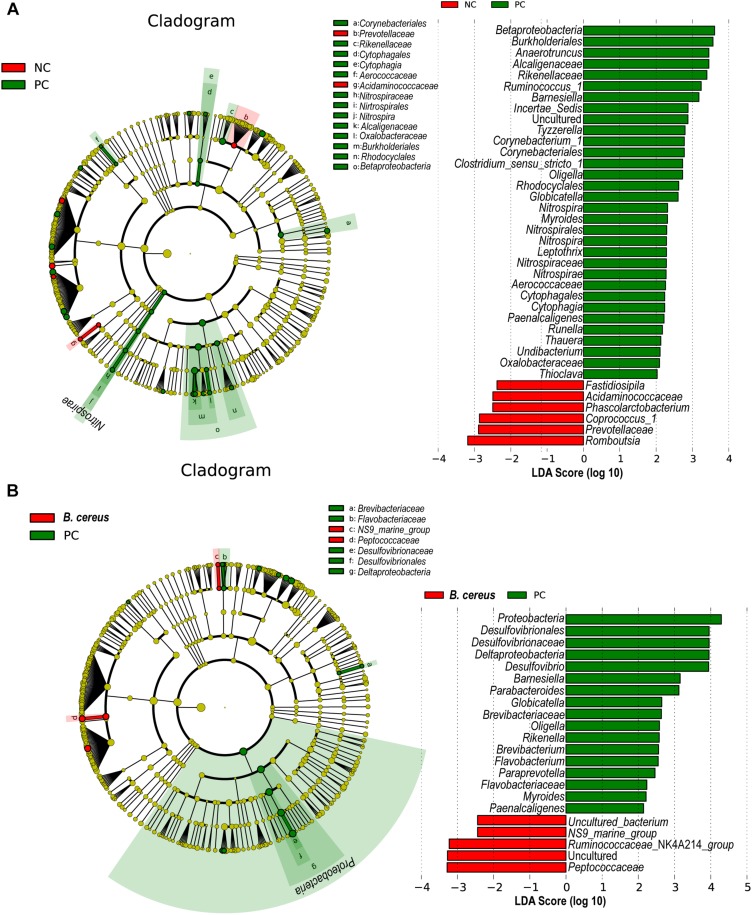
Effects of pretreatment with B. cereus on alterations in gut bacterial taxonomic abundance during D-GalN-induced acute liver injury. Bacterial taxa identified as differentially abundant between groups according to the LEfSe. Bacterial taxa of the probiotic group were compared with those of the PC group at different levels. Green indicates bacterial taxa with a higher abundance in the PC group, and red indicates bacterial taxa with a higher abundance in the other group. (A) The comparison between the NC and PC group. (B) The comparison between the PC and B. cereus group (NC group, n = 7; PC group, n = 6; B. cereus group, n = 7); NC, negative control; PC, positive control; LEfSe, linear discriminant analysis effect size.